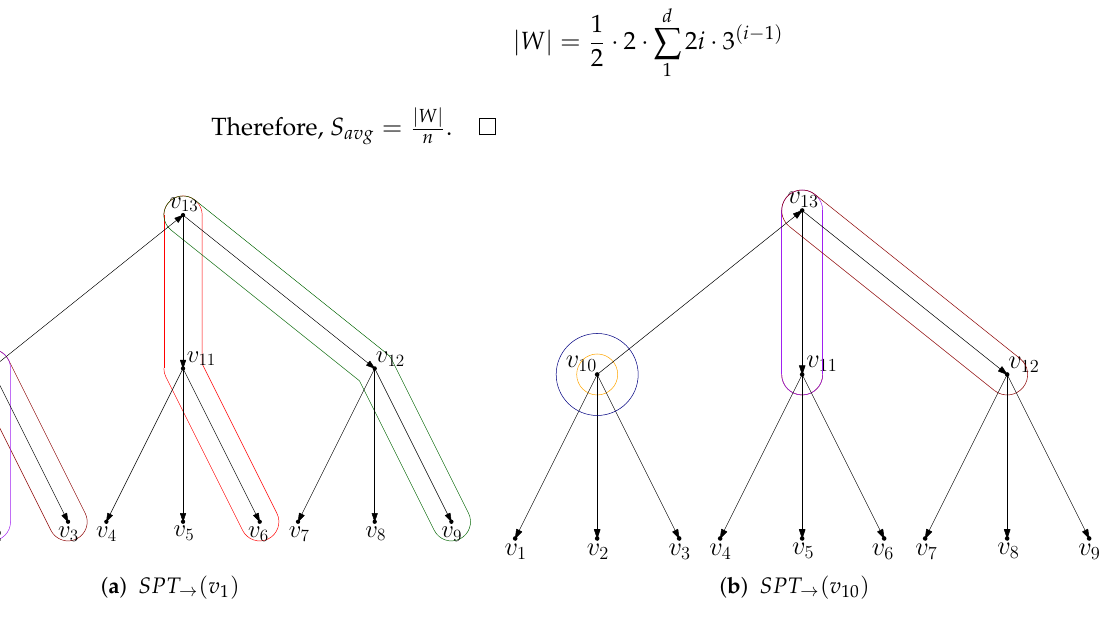
Figure 9. Shortest path trees.